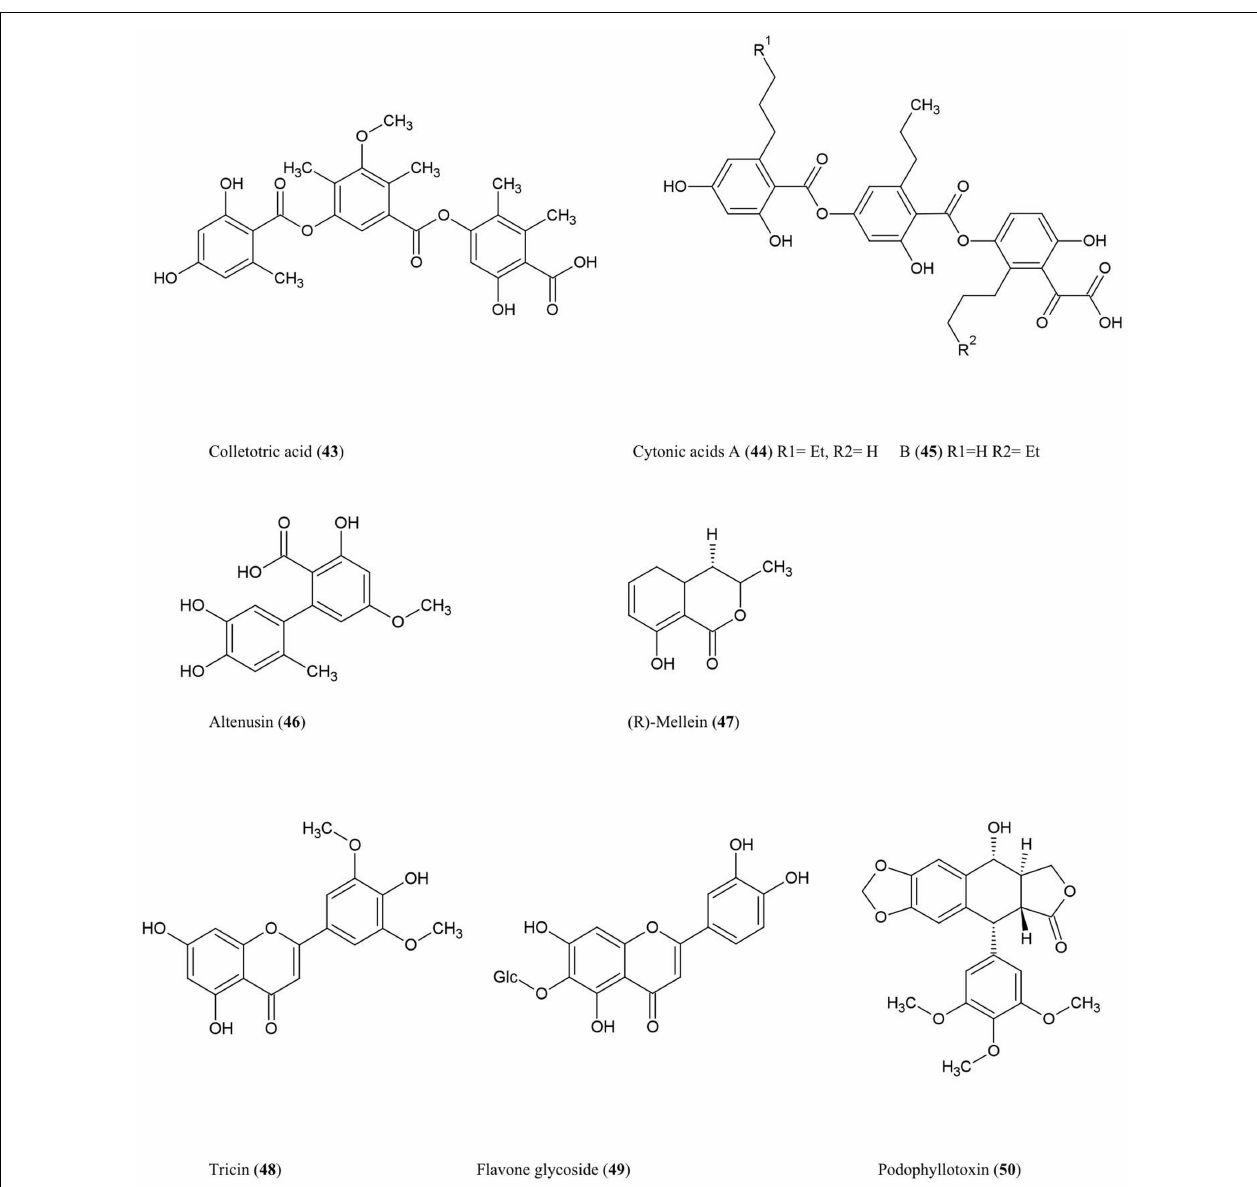
FIGURE 5 | Structures of phenolic compounds of fungal endophyte origin (43–50) (structures of simple structures 38–42 are not shown).